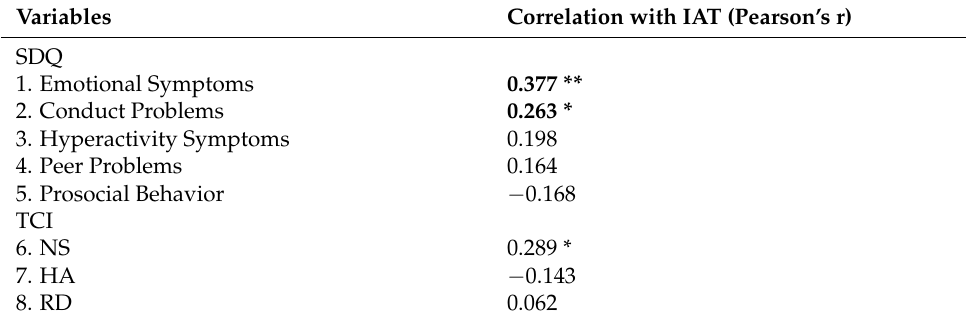
Table 2. Correlations of IAT scores to SDQ and TCI